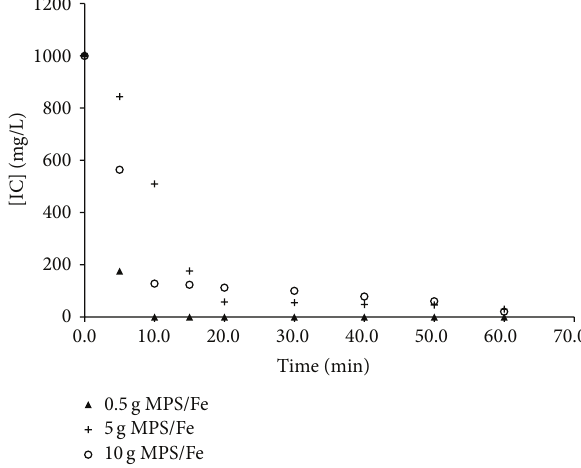
Figure 9: Effect catalyst loading on indigo carmine concentration